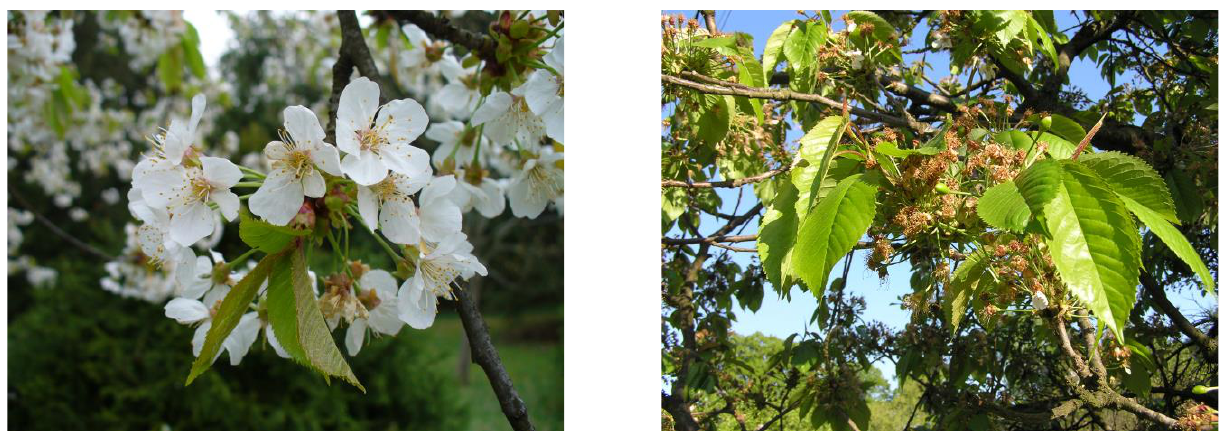
Figure 2. Beginning of flowering and end of flowering of the cherry tree ( Cerasus avium ).